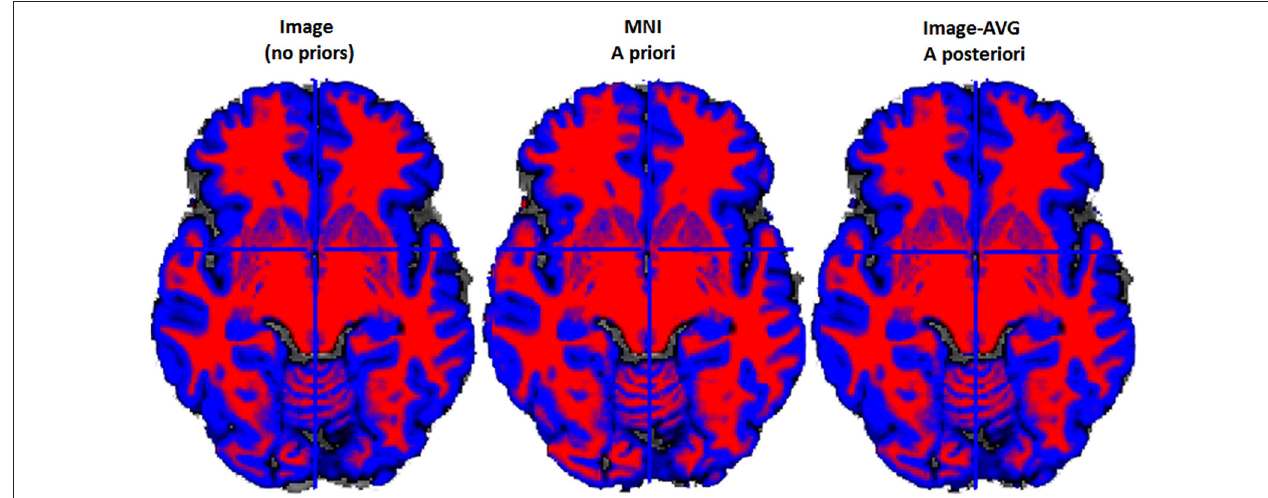
MNI seems to classify more voxels as WM and fewer voxels as GM. Age-appropriate (“Image-AVG a posteriori ”) and Image match one another rather closely, however age-appropriate does seem to identify slightly more voxels as